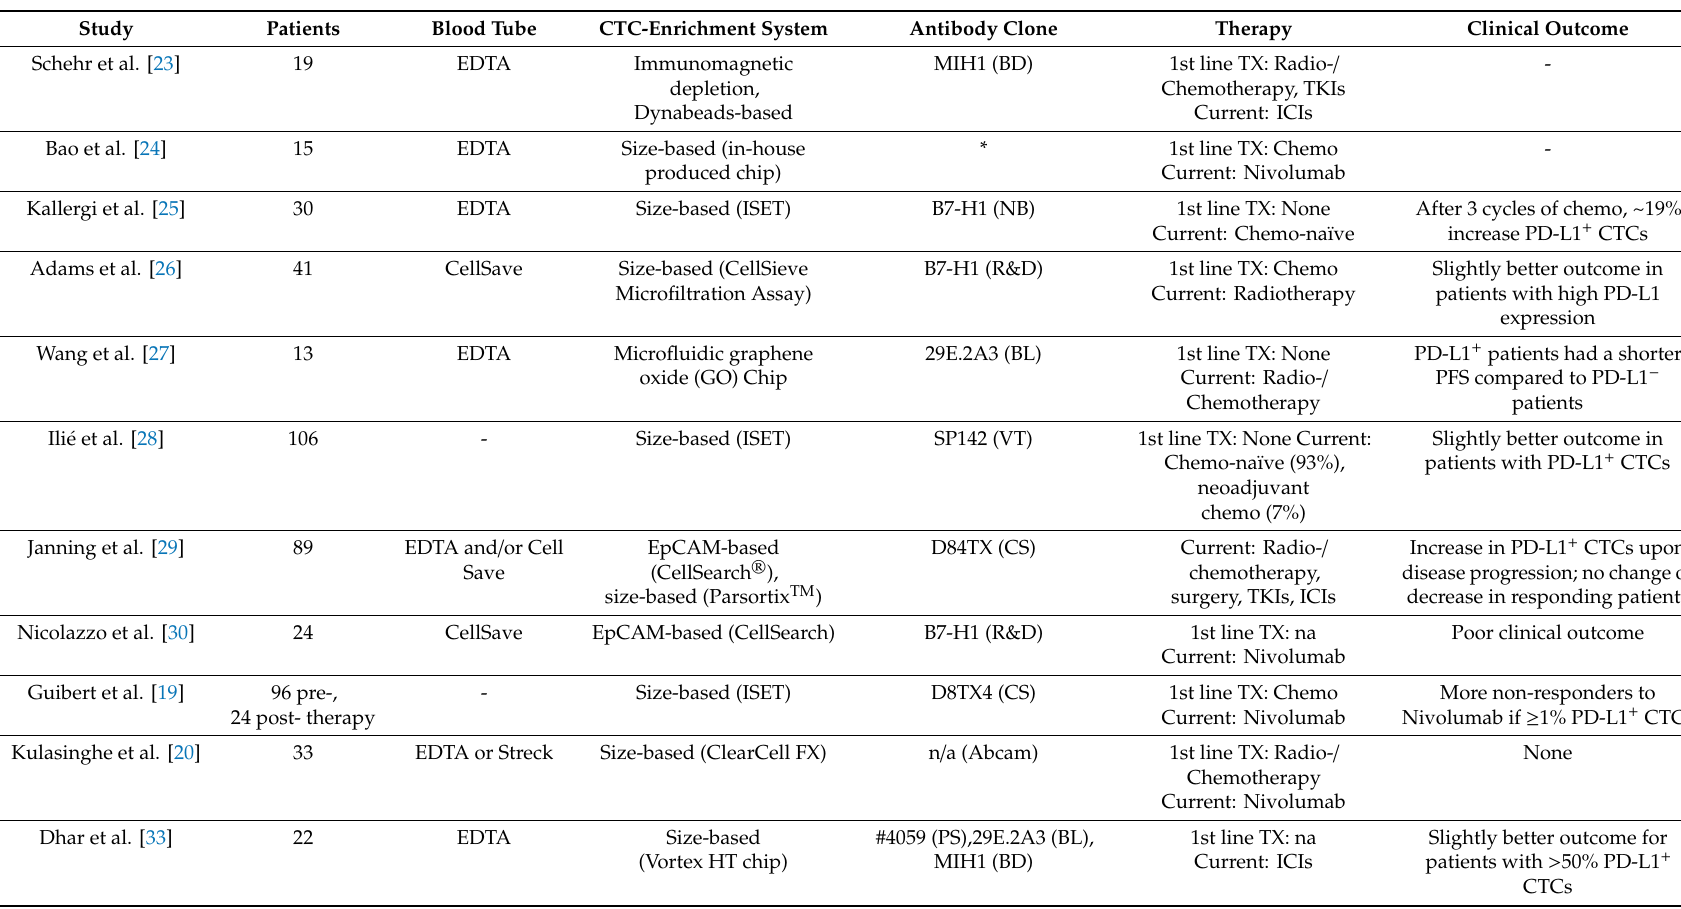
Table 1. Studies on the clinical relevance of programmed death ligand 1-positive (PD-L1 + ) circulating tumor cells (CTCs) in non-small cell lung cancer (NSCLC)